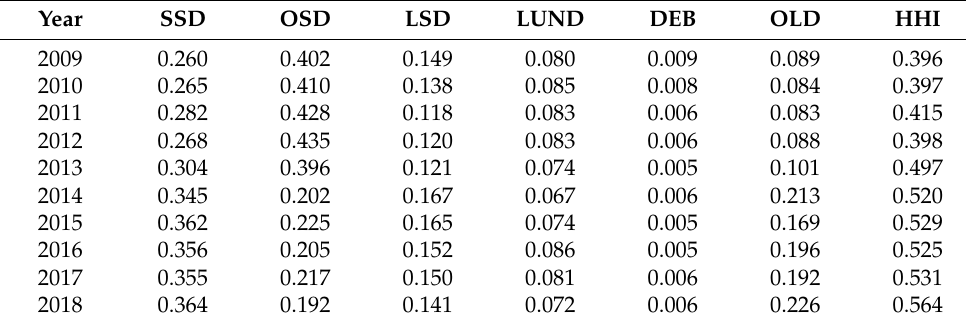
Table 5. Debt types and det specialization over time.